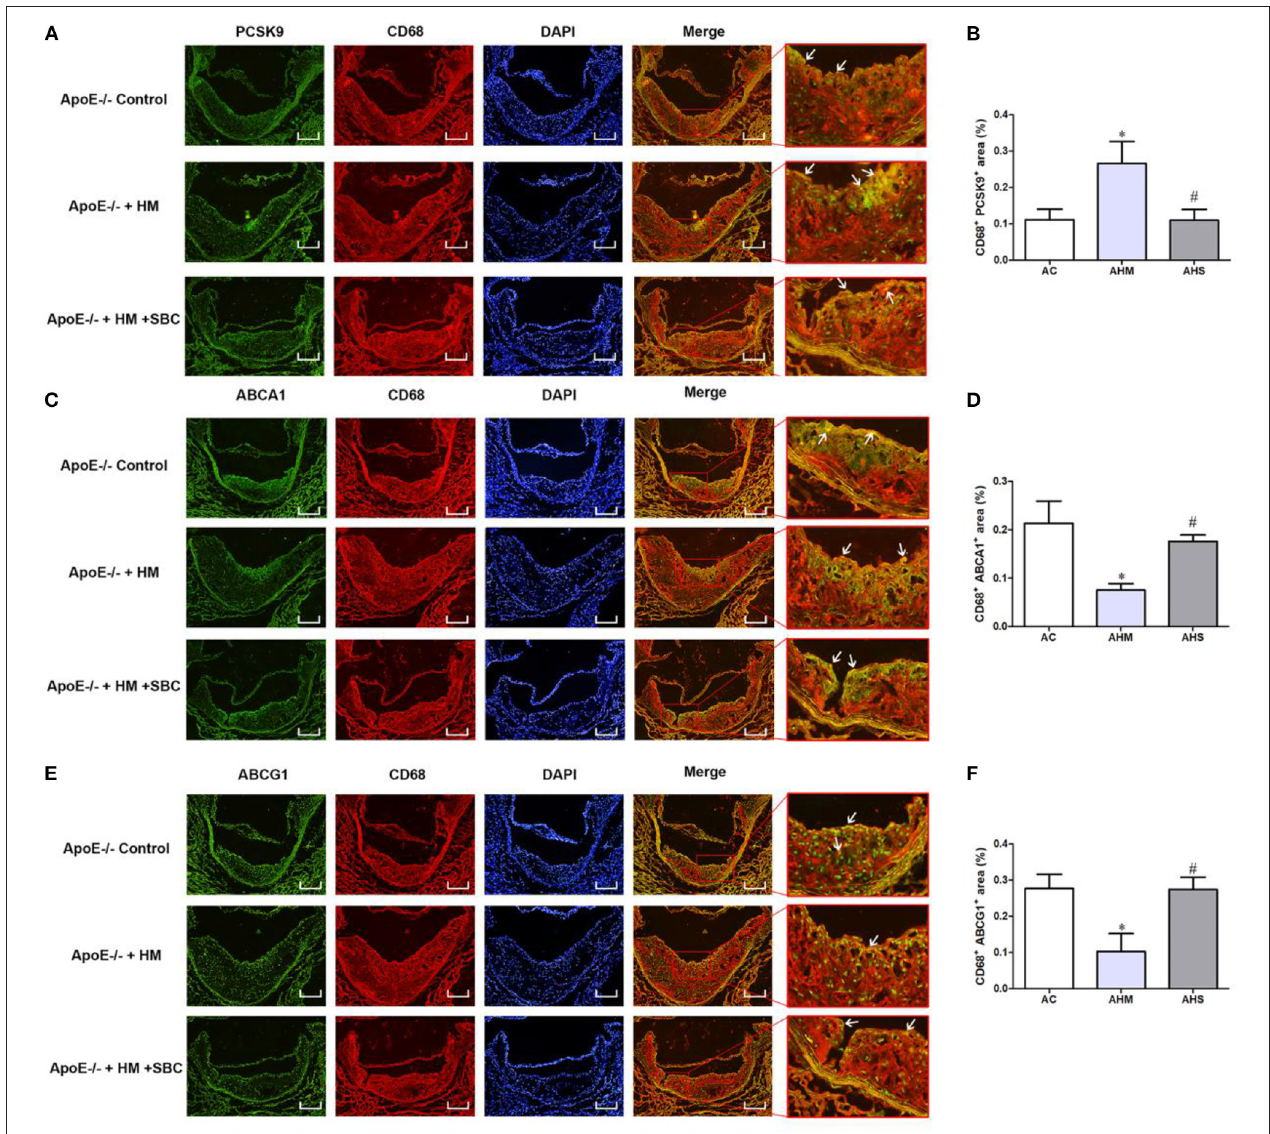
FIGURE 5 | SBC-115076 Reversed HHcy-decreased Levels of ABCA1 and ABCG1 in Macrophages from Aortic Lesions in ApoE − / − Mice. Immunofluorescent double staining and quantification of CD68 antibody and antibodies of PCSK9 (A,B) , ABCA1 (C,D) and ABCG1 (E,F) (white arrows pointed). Green indicated CD68, red indicated PCSK9, ABCA1 and ABCG1, blue indicated DAPI-stained cellular nuclei and yellow indicated double-positive macrophages with 16 × Magnification. Data represent mean ± standard error of the mean (SEM) ( n = 12 in each group). * p < 0.05 vs. control group (AC group). # p < 0.05 vs. HHcy group (AHM group). Hcy, homocysteine; HHcy, hyperhomocyteniemia; HM, methionine; SBC, SBC-115076; AC, ApoE − / − mice with chow diet; AHM, ApoE − / − mice with methionine treatment; AHS, ApoE − / − mice with methionine + SBC treatment. Scale bar = 100 µ